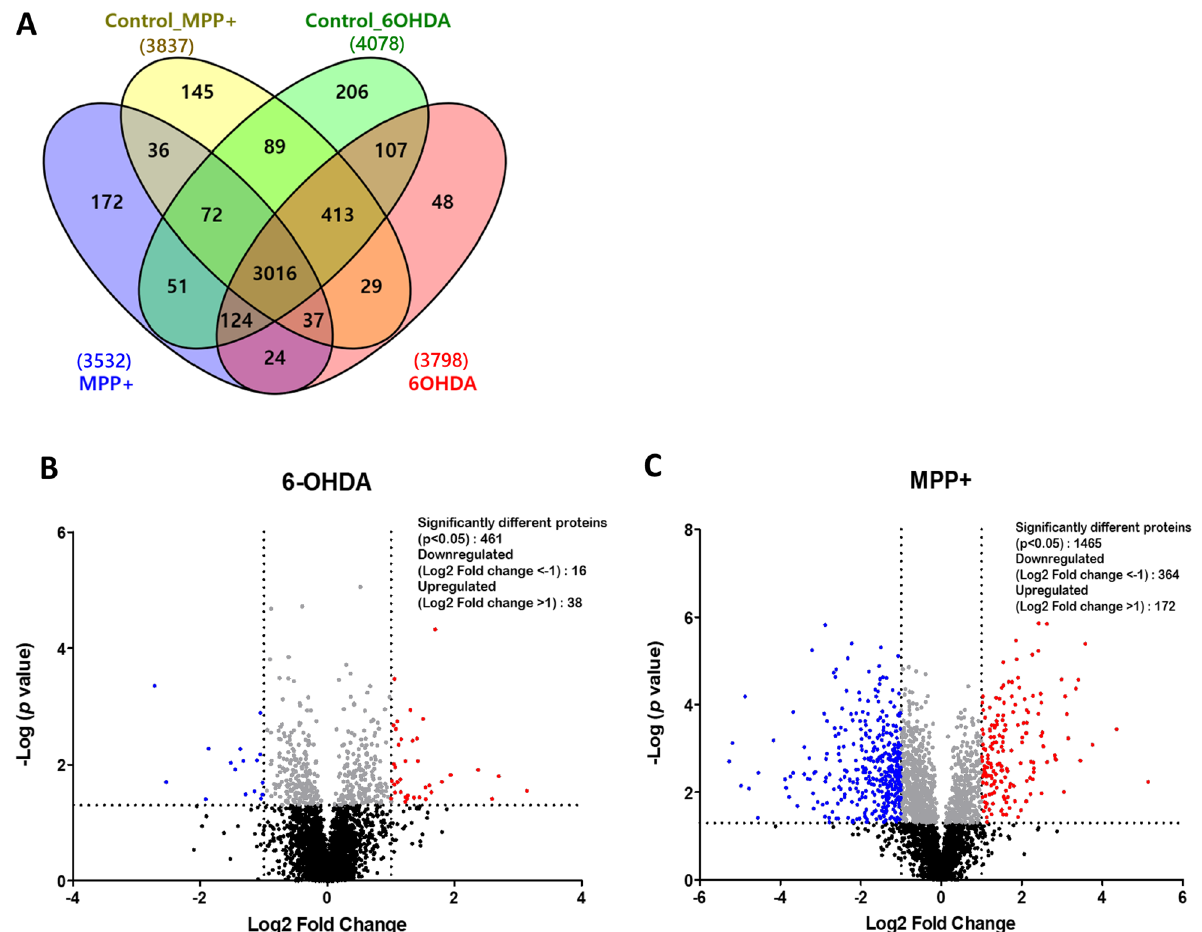
Fig. 2 A comprehensive overview of proteomics. A Venn diagram showing the number of identified proteins in each of the following four proteome sets: 6‑OHDA control, 6‑OHDA‑treated, MPP control, and MPP ‑treated. Volcano plot shows the differentially regulated proteins in B + + 6‑OHDA‑induced neurodegeneration in SH‑SY5Y cells and C MPP ‑induced neurodegeneration in SH‑SY5Y cells. The horizontal coordinate ( X ‑axis) + represents the difference in fold change (logarithmic transformation at the base of 2), and the vertical coordinate ( Y ‑axis) represents the significant difference in p value (logarithmic transformation at the base of 10). Proteins that are onefold significantly upregulated are presented as red dots, while those that are onefold downregulated are shown as blue dots. Proteins with a fold change less than onefold change are presented as gray dots. Black dots represent proteins that do not have a significant fold change. (For interpretation of the references to color in this figure legend, the reader is referred to the Web version of this article). 6-OHDA 6‑hydroxydopamine; MPP +